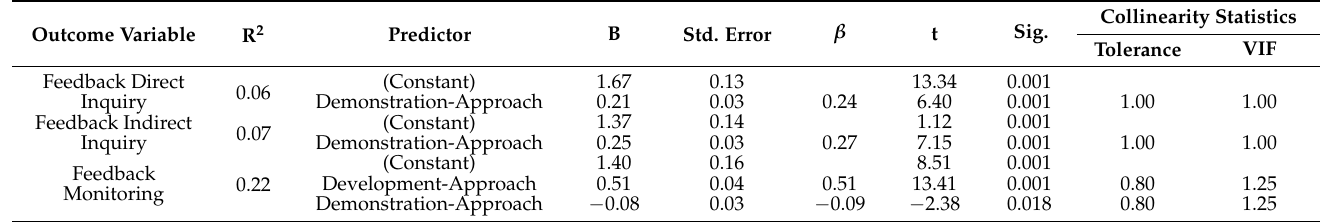
Table 3. Predictive Roles of Chinese EFL Learners’ Achievement Goals on FSB.